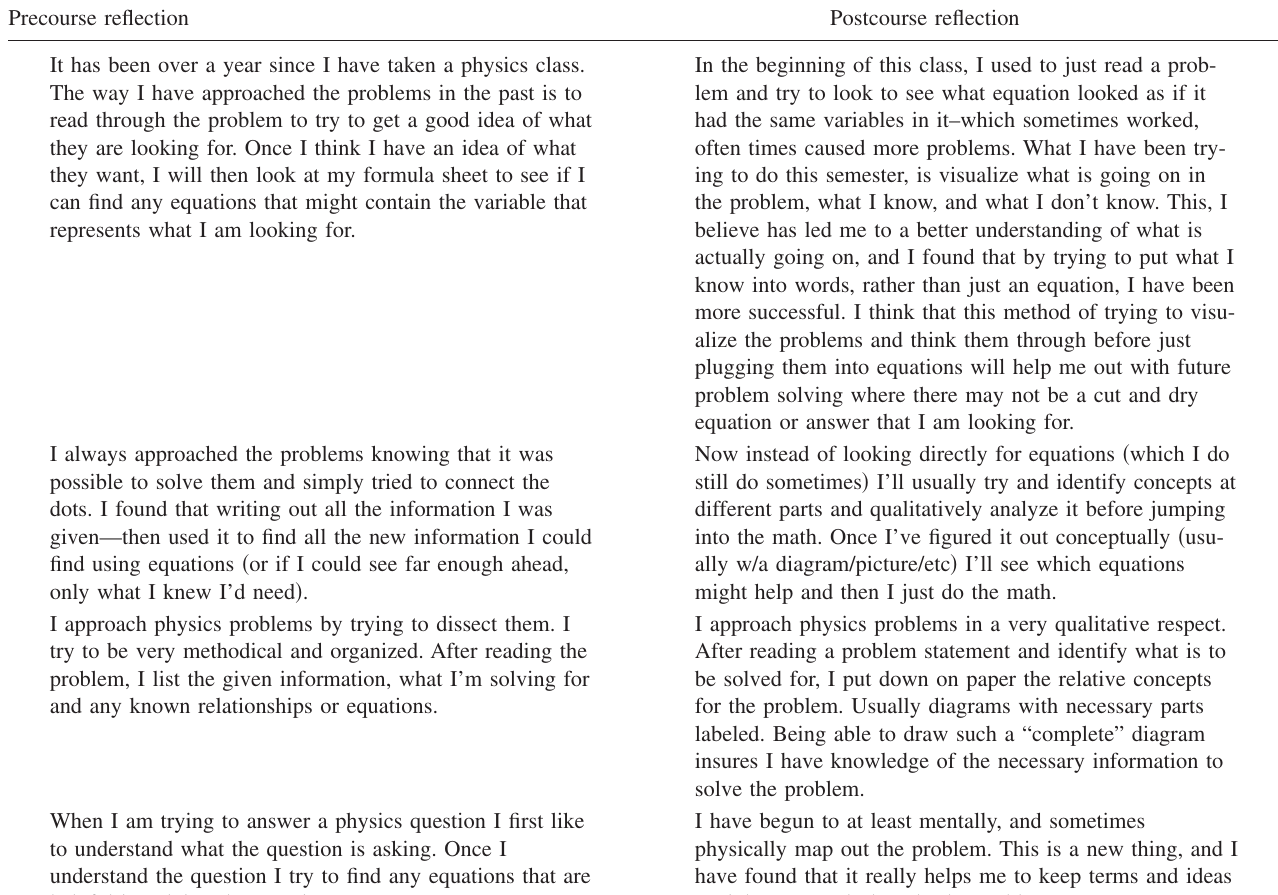
TABLE II. Examples of comments from the same student that showed large growth from the beginning to the end of the semester. Precourse reflection